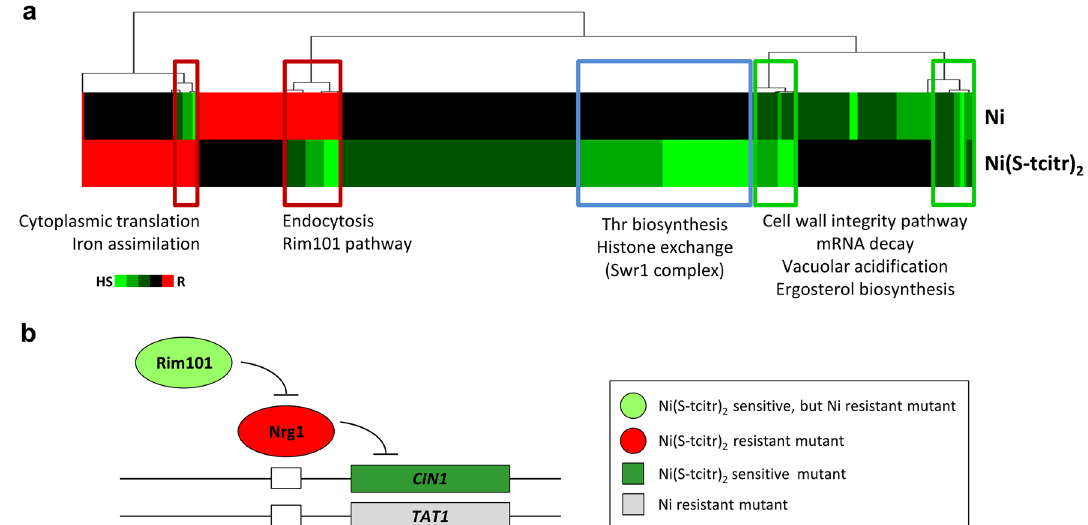
Figure 2. Distinct chemogenomic profiles of Ni(S-tcitr) 2 and free nickel ions. ( a ) Two-dimensional hierarchical clustering of the chemical-genetic profiles of Ni(S-tcitr) 2 and NiCl 2 in yeast. Genes and compounds are represented on the vertical and horizontal axis; chemical-genetic interactions are shown in green and red for sensitive and resistant mutants, respectively. Genes involved in ‘threonine (Thr) biosynthetic process’ and ‘histone exchange (Swr1 complex)’ displayed chemical-genetic interactions only with Ni(S-tcitr) 2 . Deletion of genes involved in ‘endocytosis’, ‘Rim101 pathway’, ‘cytoplasmic translation’ and ‘iron assimilation’ displayed opposite phenotypes (sensitivity vs resistance) when treated with Ni(S-tcitr) 2 or NiCl 2 . ( b ) Rim101 pathway deletion mutants differently respond to Ni(S-tcitr) 2 or NiCl 2 in S. cerevisiae . Data for NiCl 2 were derived and re-elaborated from Ruotolo et al . 34